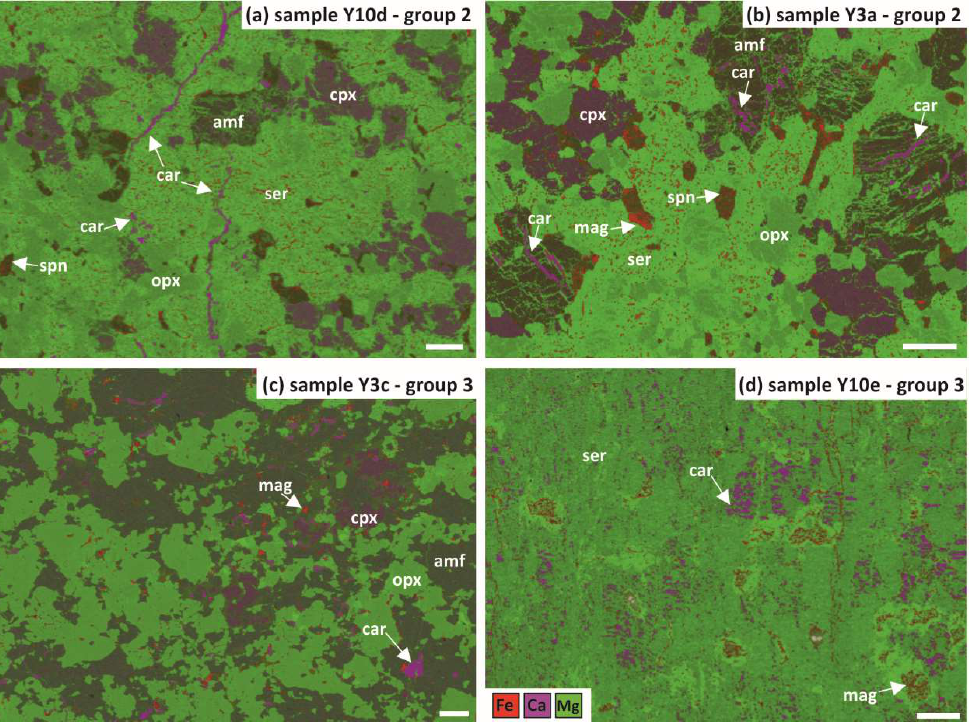
Figure 8. Element maps detailing the mineralogical and textural associations of the carbonate minerals. White scale bar = 1 mm. Abbreviations as in Figure 7.